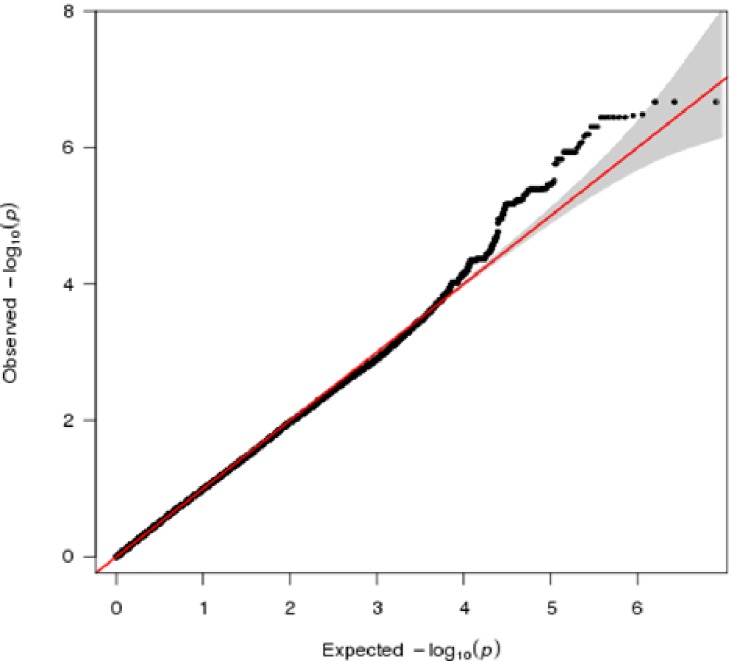
Quantile-quantile plot for test statistic inflation, lambda median = 1.026.